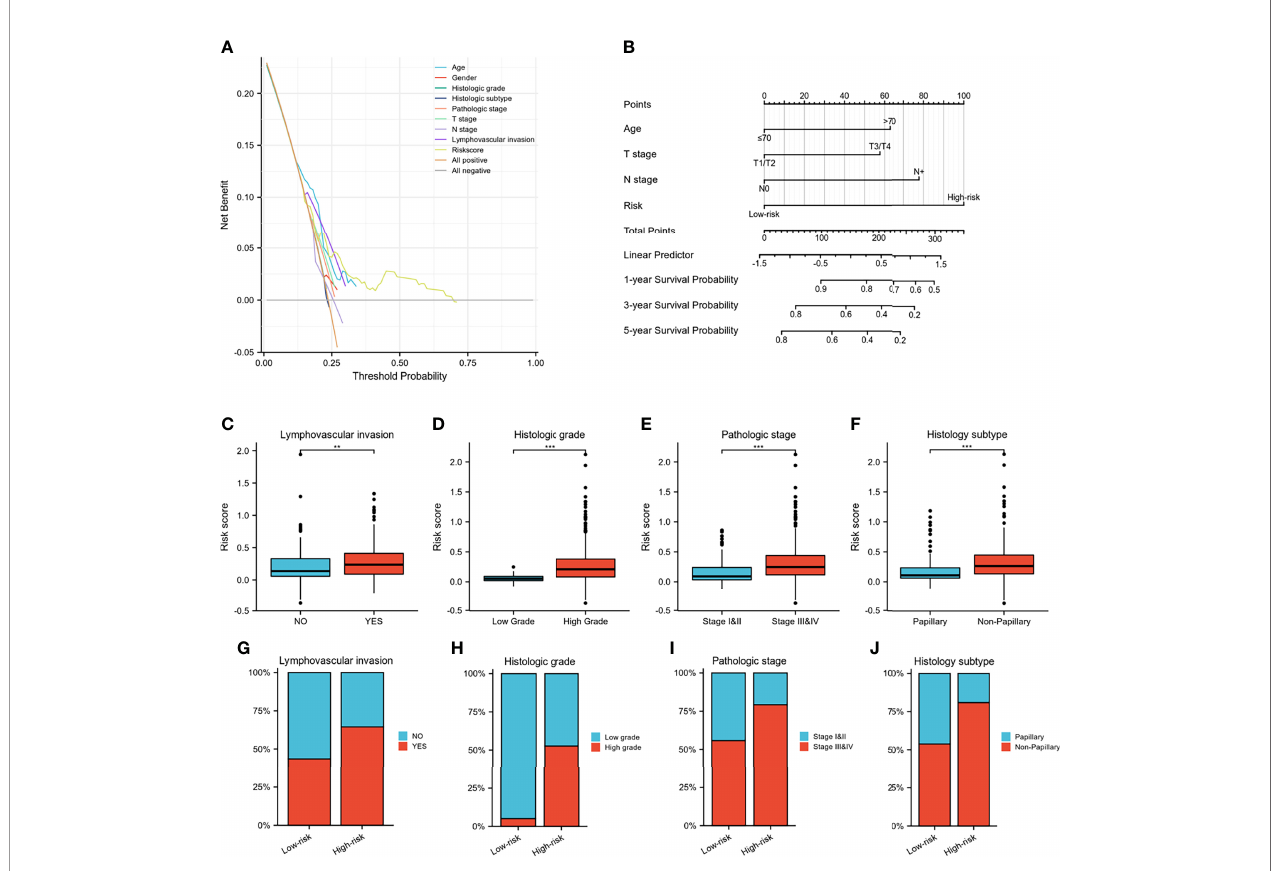
FIGURE 8 | Validation of IGFBP7-based immune risk model. (A) DCA curve for assessment of the clinical usefulness of the risk model. (B) Nomogram for predicting the probability of 1-, 3-, and 5-year survival probability for BLCA patients. (C – J) Differences in clinicopathological features between the high- and low-risk groups in the TCGA cohort. **p<0.01;